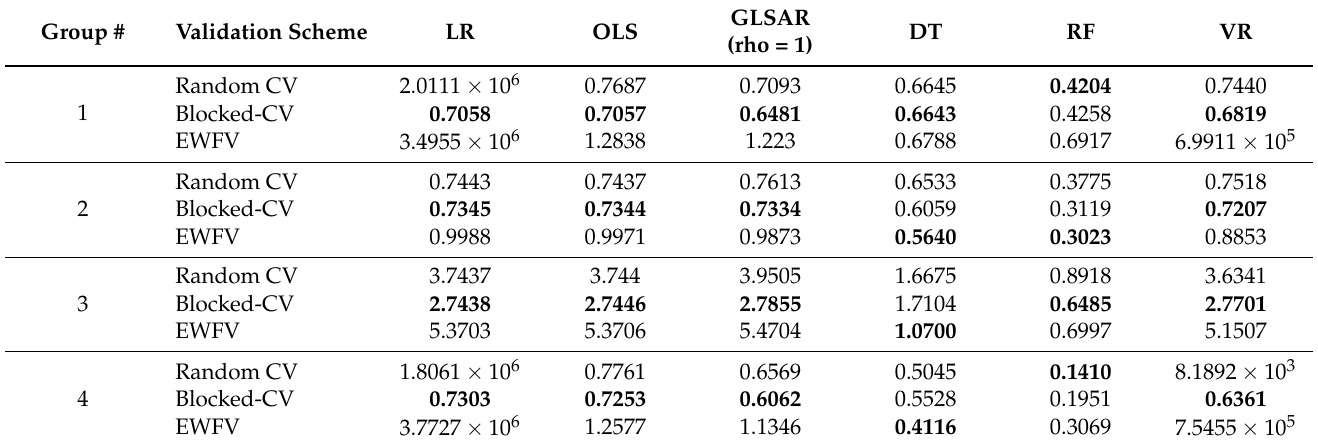
Table 5. Differences between validation MAPE and test MAPE for all